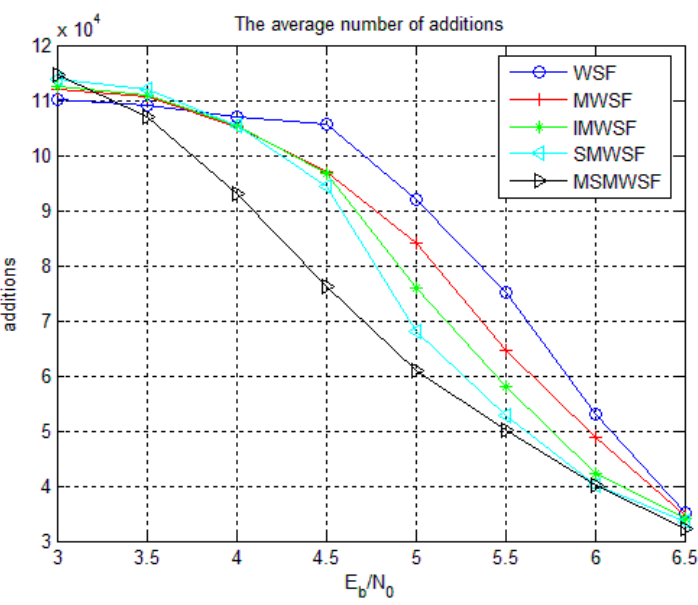
Figure 10. The average number of addition operations of five algorithms under Code 1.